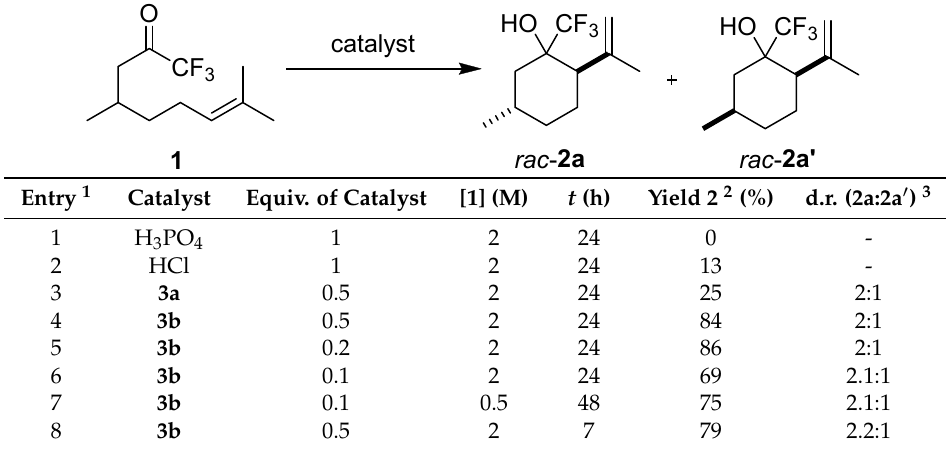
Figure 1. Brønsted acids screened for carbonyl-ene reaction. Table 1. Optimization of carbonyl-ene cyclization of trifluoroketone 1 .